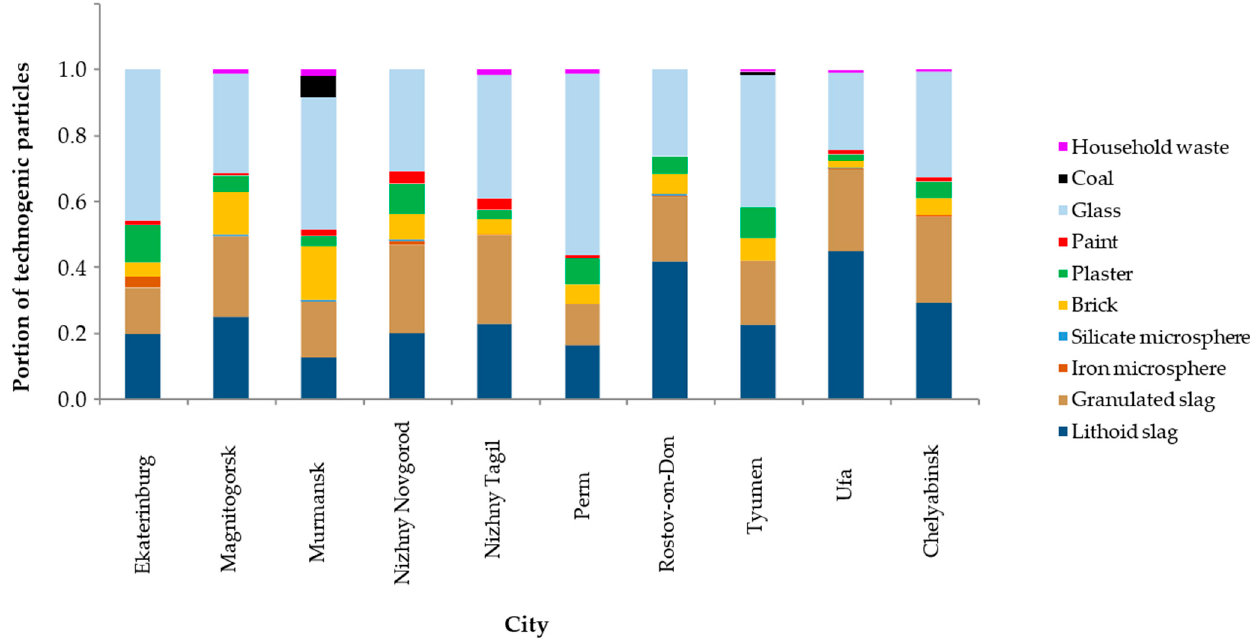
Figure 5. Distribution of the amount of different types of technogenic particle in the cities in the granulometric fraction of 0.1–0.25 mm.